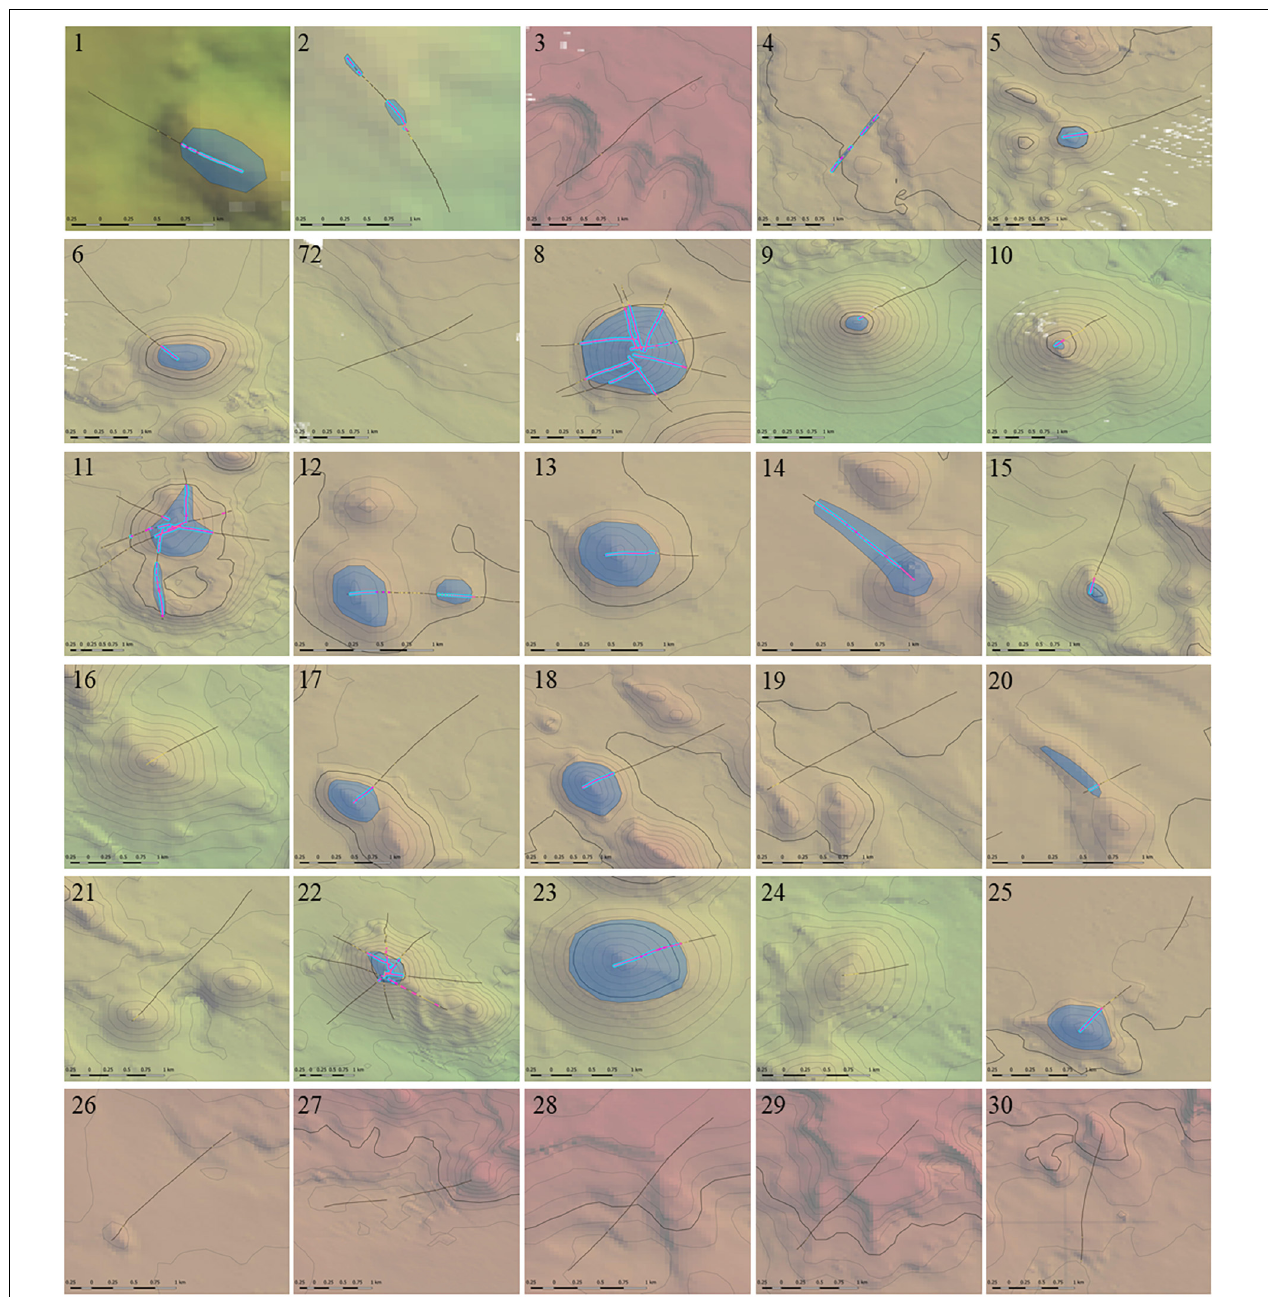
FIGURE 11 | The estimated extent (size) of Solenosmilia variabilis coral reef VME at individual study sites extrapolated from coral reef VME mapped along transects. Mapping method as per Figure 9 , with coral reef VME extent underlaid as gray polygons. Scenario uses criteria of 25% cover of coral reef and 1 live head, a moving window with a ratio of 3:5, and a live head threshold of 5.6). Depth contours: 50 m intervals with 950 and 1350 lines